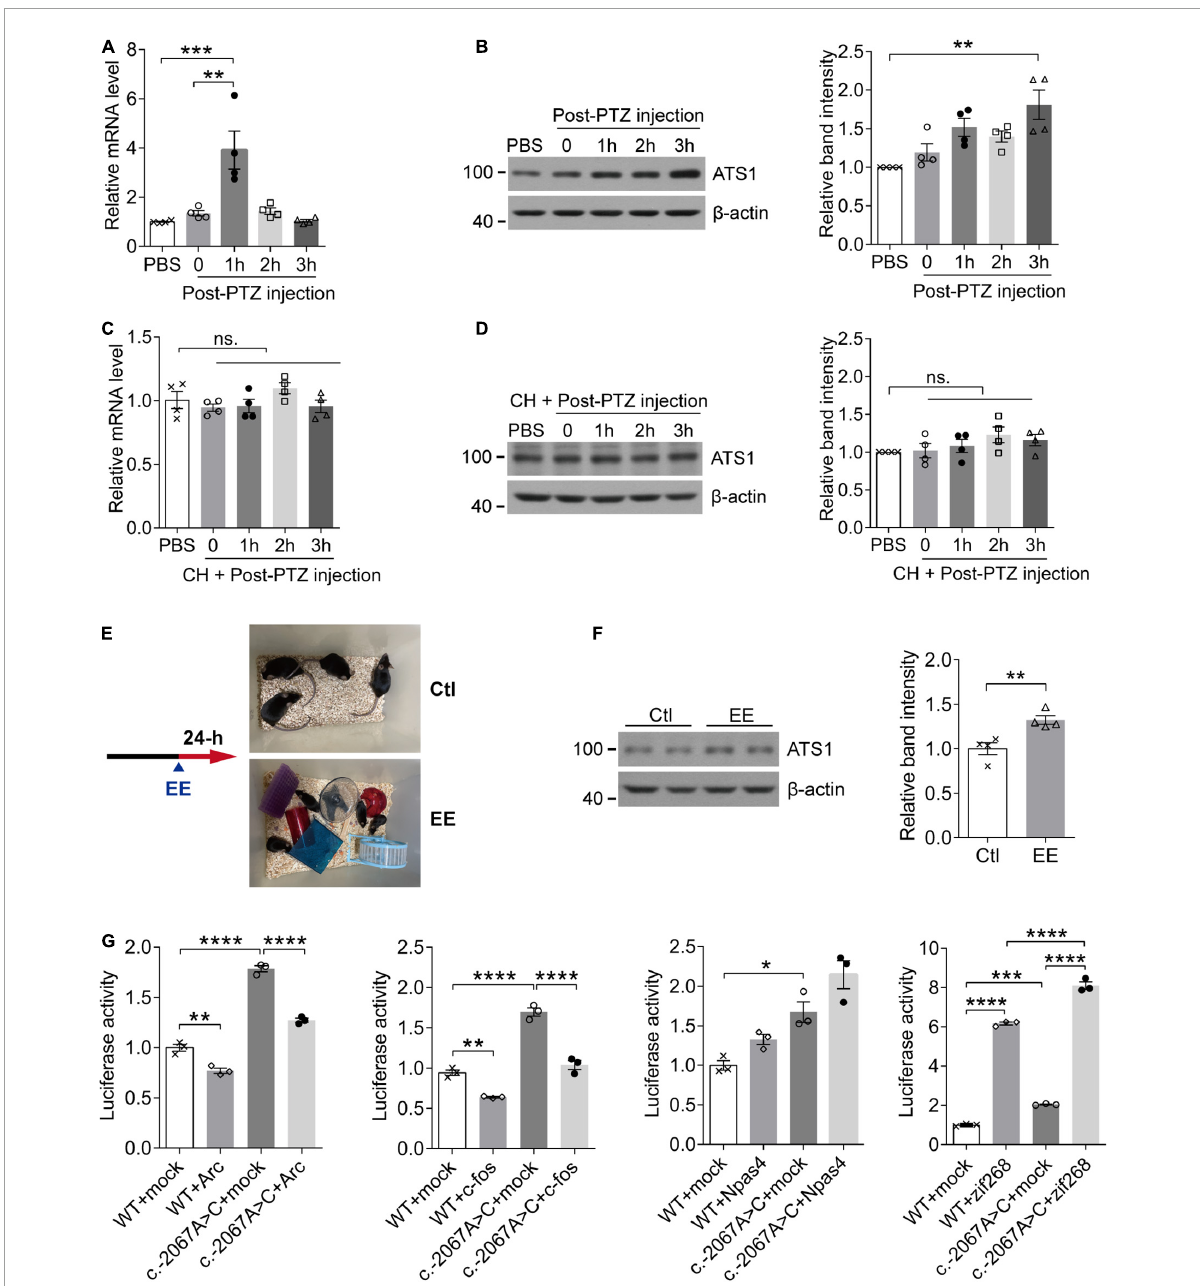
FIGURE3 The activity-dependent expression pattern of ATS1 through the potential mediation of zif268. (A,B) Ten week-old WT male mice were intraperitoneally injected with PTZ to induce synaptic activation and sacrificed at different timepoints. (A) The Ats1 mRNA was significantly induced 1-h post-injection ( n = 4, P < 0.001, 1 h vs. PBS; P < 0.01, 1 h vs. 0, one-way ANOVA). (B) Western blot of ATS1 at different timepoints. The relative band intensities showed that ATS1 was obviously upregulated 3-h post-injection ( n = 4, P < 0.01, 3 h vs. PBS, Kruskal-Wallis test). (C,D) Ten week-old WT male mice were intraperitoneally injected with CH 30 min before PTZ administration and sacrificed at different timepoints. No significant difference was detected for Ats1 (C) mRNA or (D) protein levels when compared with PBS group ( n = 4, one-way ANOVA). (E) Scheme of EE experiments. (F) Western blot of ATS1 in hippocampus after 24-h EE-housing. The relative band intensities indicated upregulated expression of ATS1 ( n = 4, P < 0.01, EE vs. Ctl, Student’s t -test). (G) HEK 293T cells transfected with the ATS1 promoter (WT or c.–2067A > C) and immediate early gene plasmids ARC , FOS , NPAS4, or ZIF268 were subjected to the dual-luciferase assay. The relative luciferase activity demonstrated that zif268 multiplied ATS1 promoter activity significantly ( n = 3, P < 0.0001, WT + zif268 vs. WT + mock; P < 0.0001, c.–2067A > C + zif268 vs. c.–2067A > C + mock; P < 0.0001, c.–2067A > C + zif268 vs. WT + zif268, one-way ANOVA). * P < 0.05, ** P < 0.01, *** P < 0.001, **** P < 0.0001. Data were expressed as Mean ± SEM. ATS1, ADAMTS1; CH, chloral hydrate; ns.,